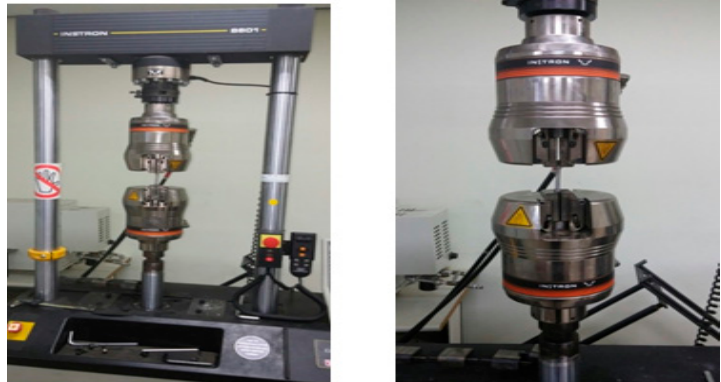
Figure 7. Material testing system (Instron 8801, 10 tons).